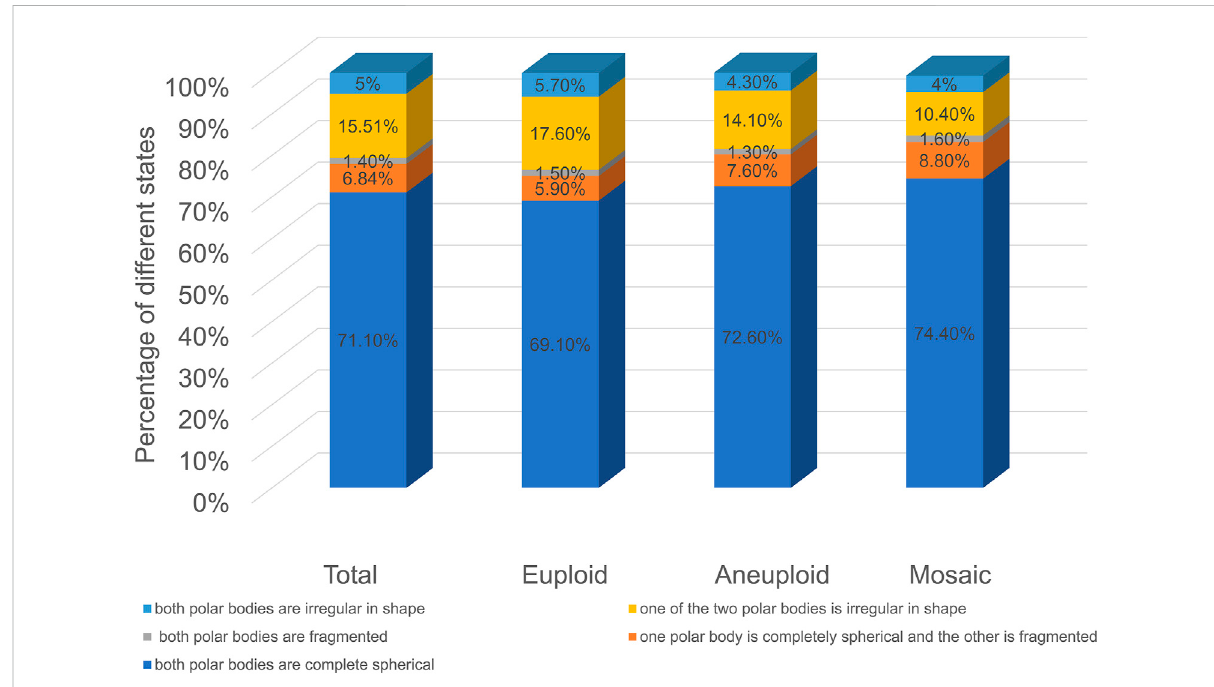
Polar body morphology and embryo euploidy.